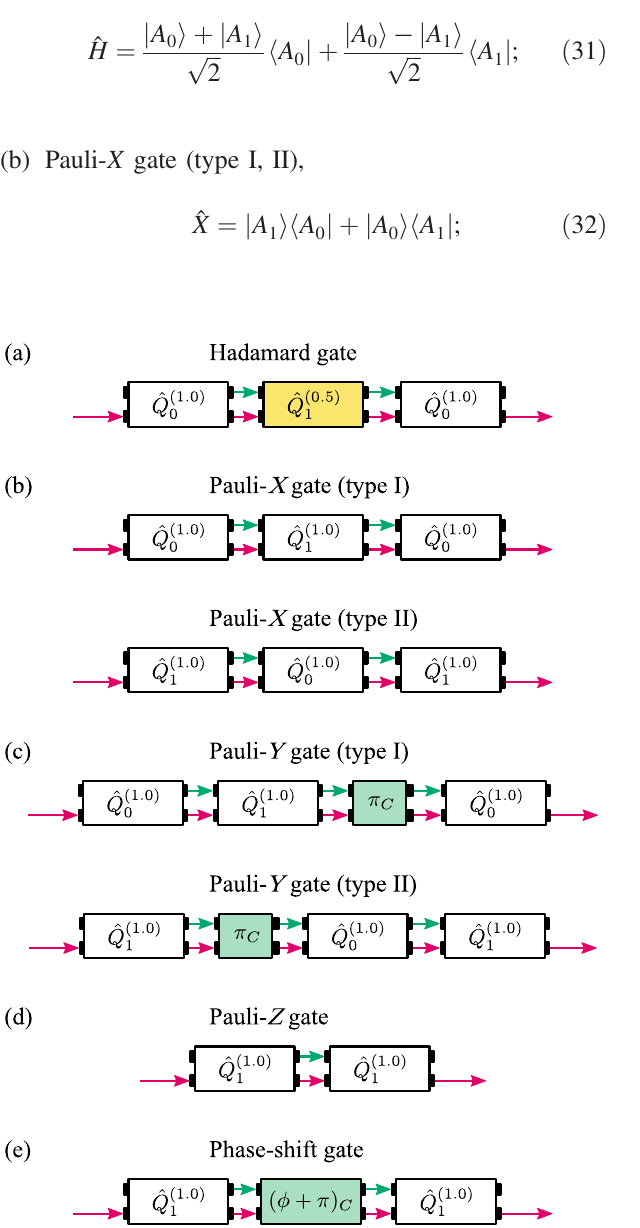
FIG. 12. Implementation of single-qubit gates for LOQC using QPGs with 100% conversion efficiency (white boxes), QPGs with 50% conversion efficiency (yellow boxes), and phase shifts of the green j C i TM (green boxes). Note that both the Pauli- X gate and the Pauli- Y gate have two possible experimental implementations, which differ in the order in which the red TMs f ð s Þ 0 ð ω Þ and f ð s Þ 1 ð ω Þ are